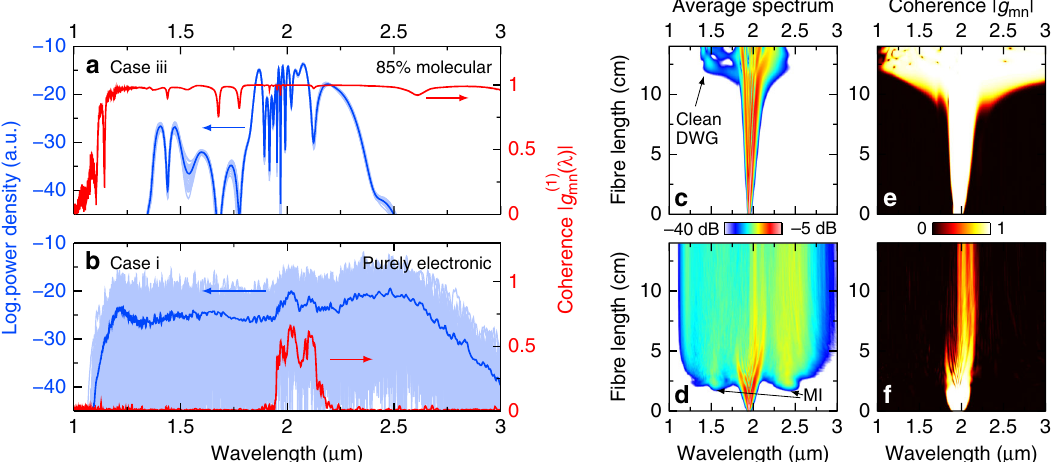
Fig. 3 Impact of hybrid soliton dynamics on coherence. Ensemble and coherence analysis of the CS 2 /silica LiCOF output (core diameter: 4.7 μ m, length: 14 cm) for ( a ) the hybrid CS 2 response ( f m = 0.85) and ( b ) an entirely instantaneous response ( f m = 0). The light blue line s refer to 50 individual spectra calculated under identical input conditions ( E p ¼ 1nJ, τ FWHM = 450 fs, λ p = 1.95 μ m, N = 41) with photon noise, the solid blue lines to the corresponding averages. The red lines represent the fi rst-order coherence (right-handed axes). c , d . Evolution of the average spectrum along the fi bre for each system (log. colour scale indicating spectral power: − 40 to − 5 dB). DWG: dispersive wave generation, MI: modulation instabilities. e , f Evolution of the fi rst-order coherence for each system ( linear colour scale : 0 to